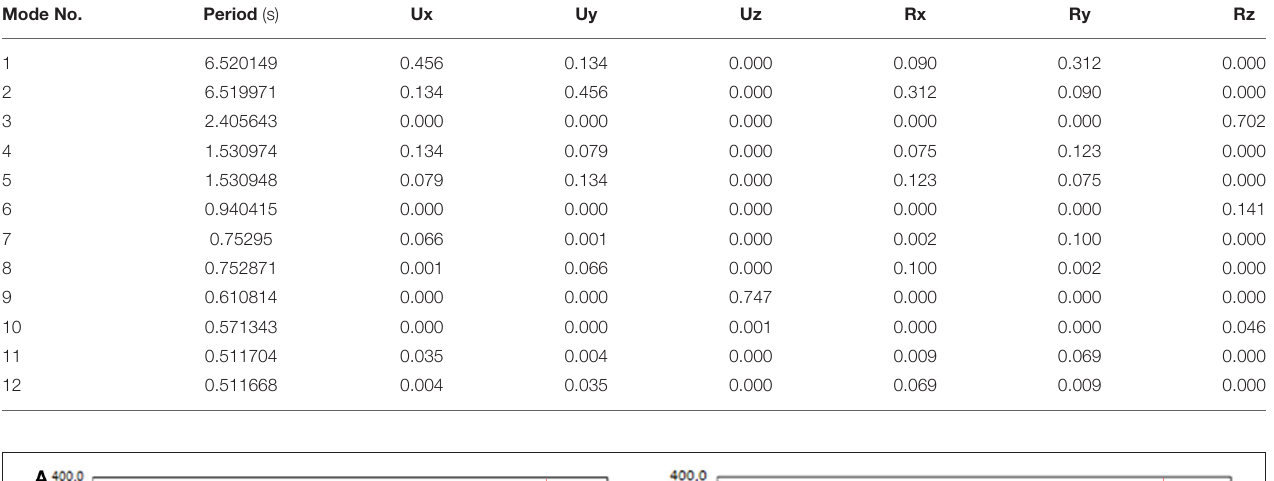
TABLE 2 | Results of the modal analysis for the model with constant member cross-sections. Mode No.